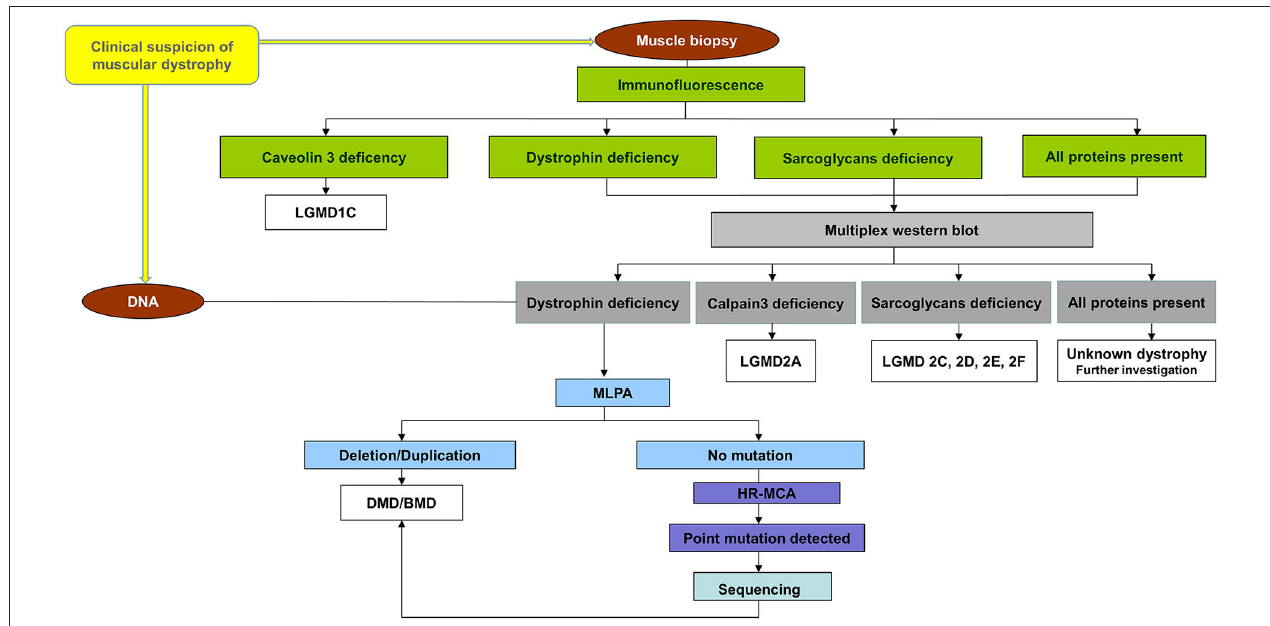
FIGURE 1 | Workflow chart for all patients referring to us. All patients were first immunohistochemical analyzed using a panel of antibodies for muscle proteins such as dystrophin, utrophin, α , β , γ , sarcoglycans caveolin-3, dysferlin, merosin, and nNOS to establish the primary protein deficiency. Based on the results obtained by immunohistochemical staining, the patients were classified into four groups: (a) patients with a deficiency of dystrophin, (b) patients with a deficiency of sarcoglycans, (c) patients with a deficiency of caveolin 3, and (d) patients with all proteins present (data not shown). Patients from the group (a), (b), and (d) were further analyzed by multiplex WB to confirm the immunohistochemical result and to identify modification of calpain-3 for the others. A total of 40 unrelated male patients identified with a deficiency of dystrophin were recruited for this study. These patients were further tested for a complete molecular characterization of the DMD gene